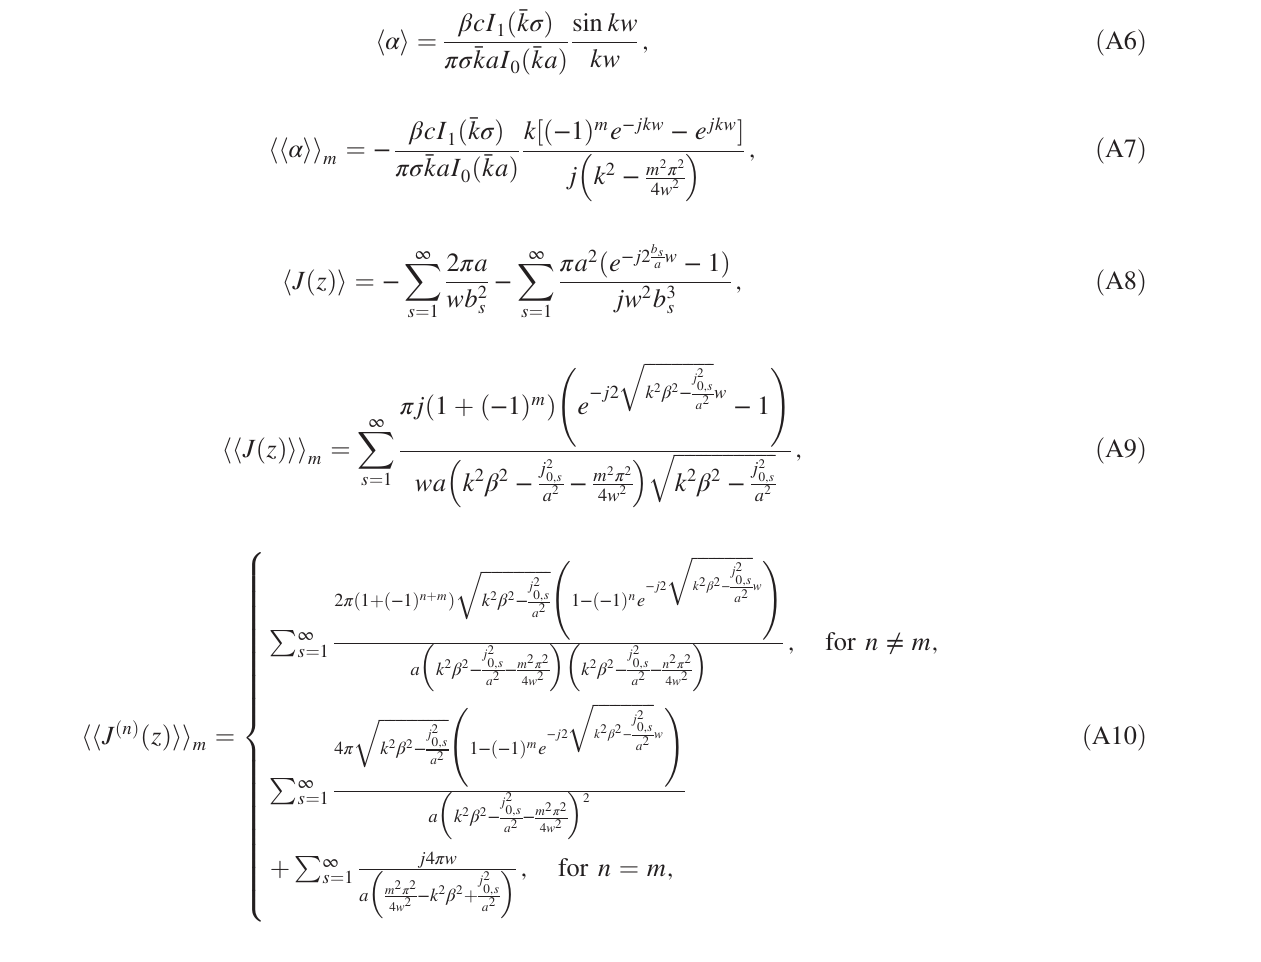
ffiffiffiffiffiffiffiffiffiffiffiffiffi